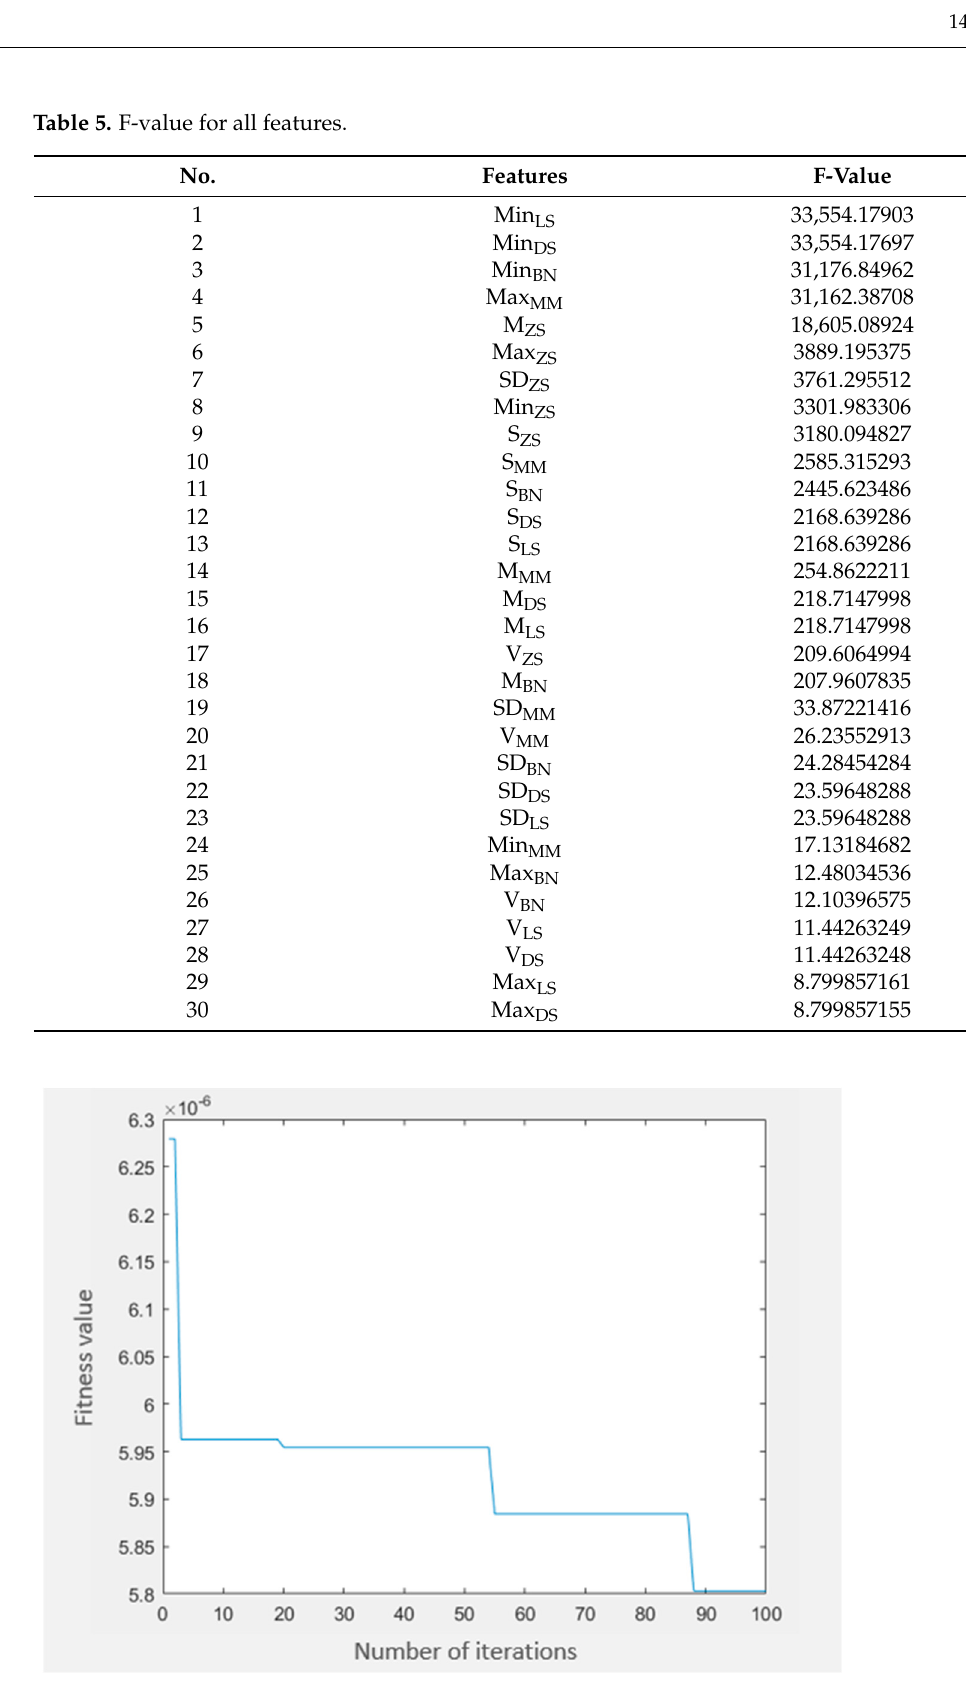
Figure 9. Convergence characteristic for BPSO in the global model.